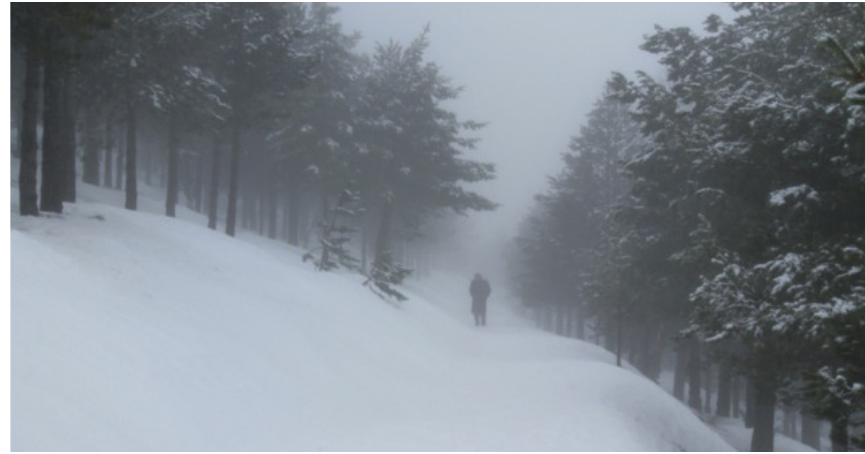
FIGURE 1 | Ori Gersht, Evaders , 2010, Still from DVD projection, Image courtesy of Mummery +